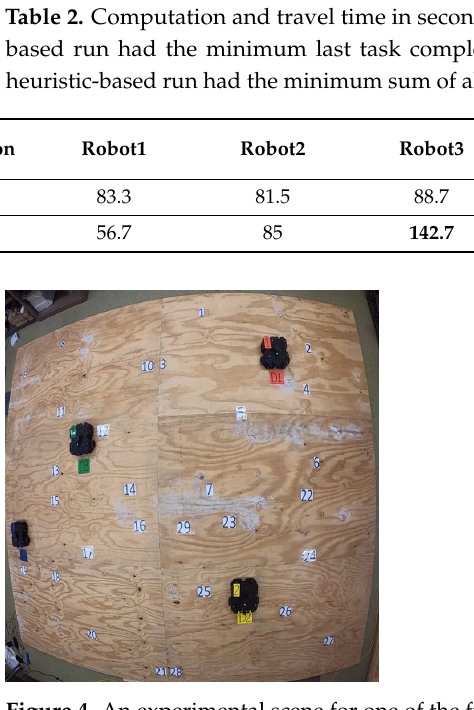
Figure 4. An experimental scene for one of the field experiments. The colored locations represent the depots, and others represent the target locations.